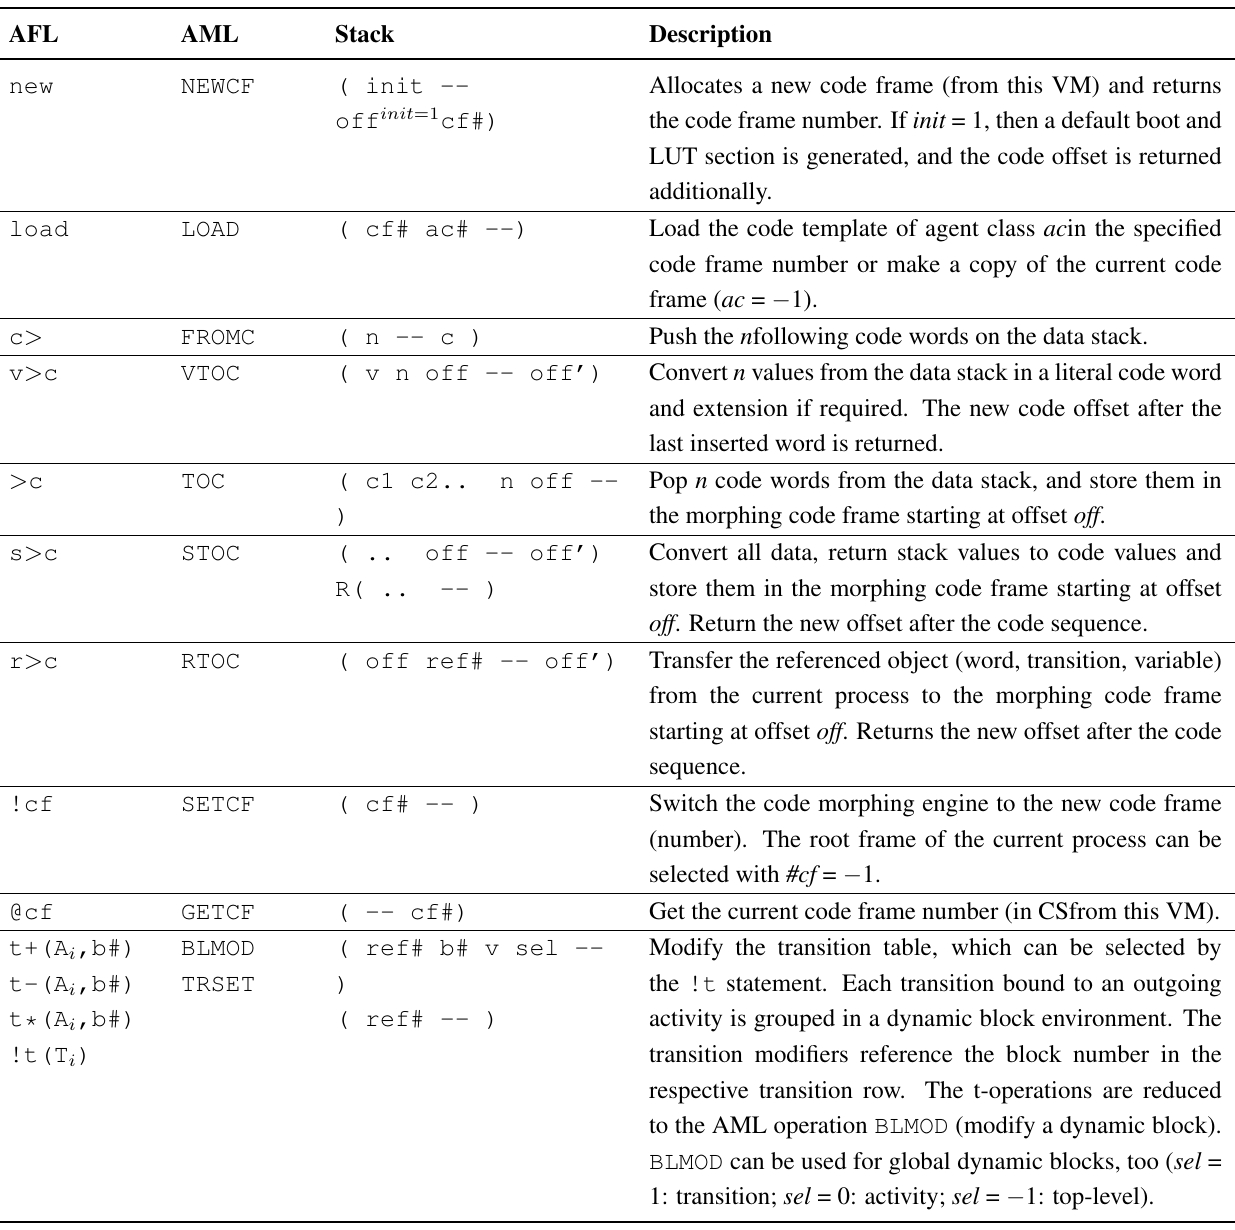
Table 4. AFL/AML code morphing words (off, code offset relative to the code segment start; cf#, code frame number; ref#, LUT object reference